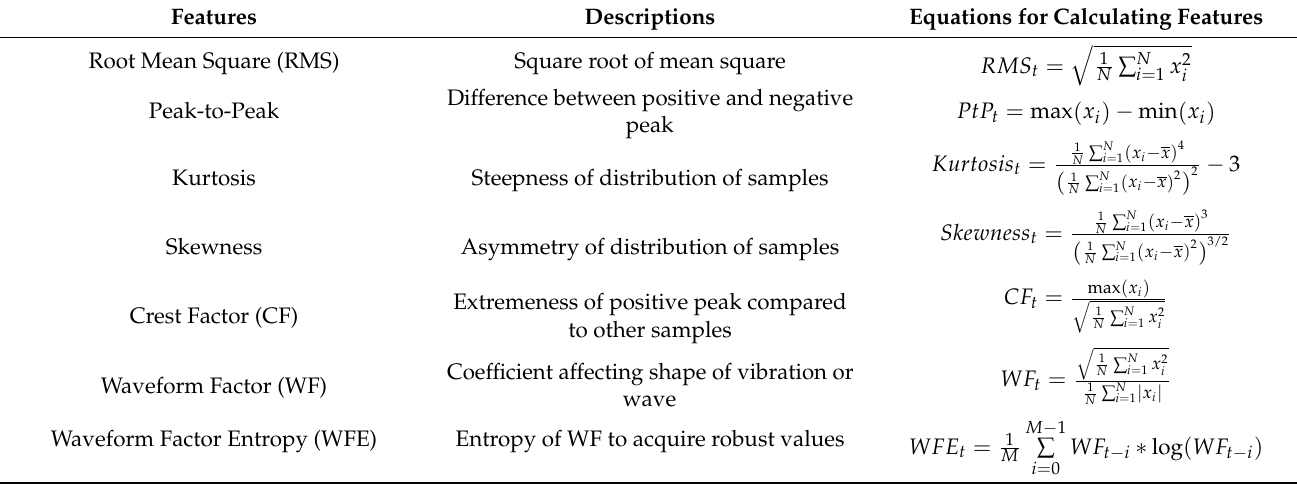
Table 3. Description and equation for calculating